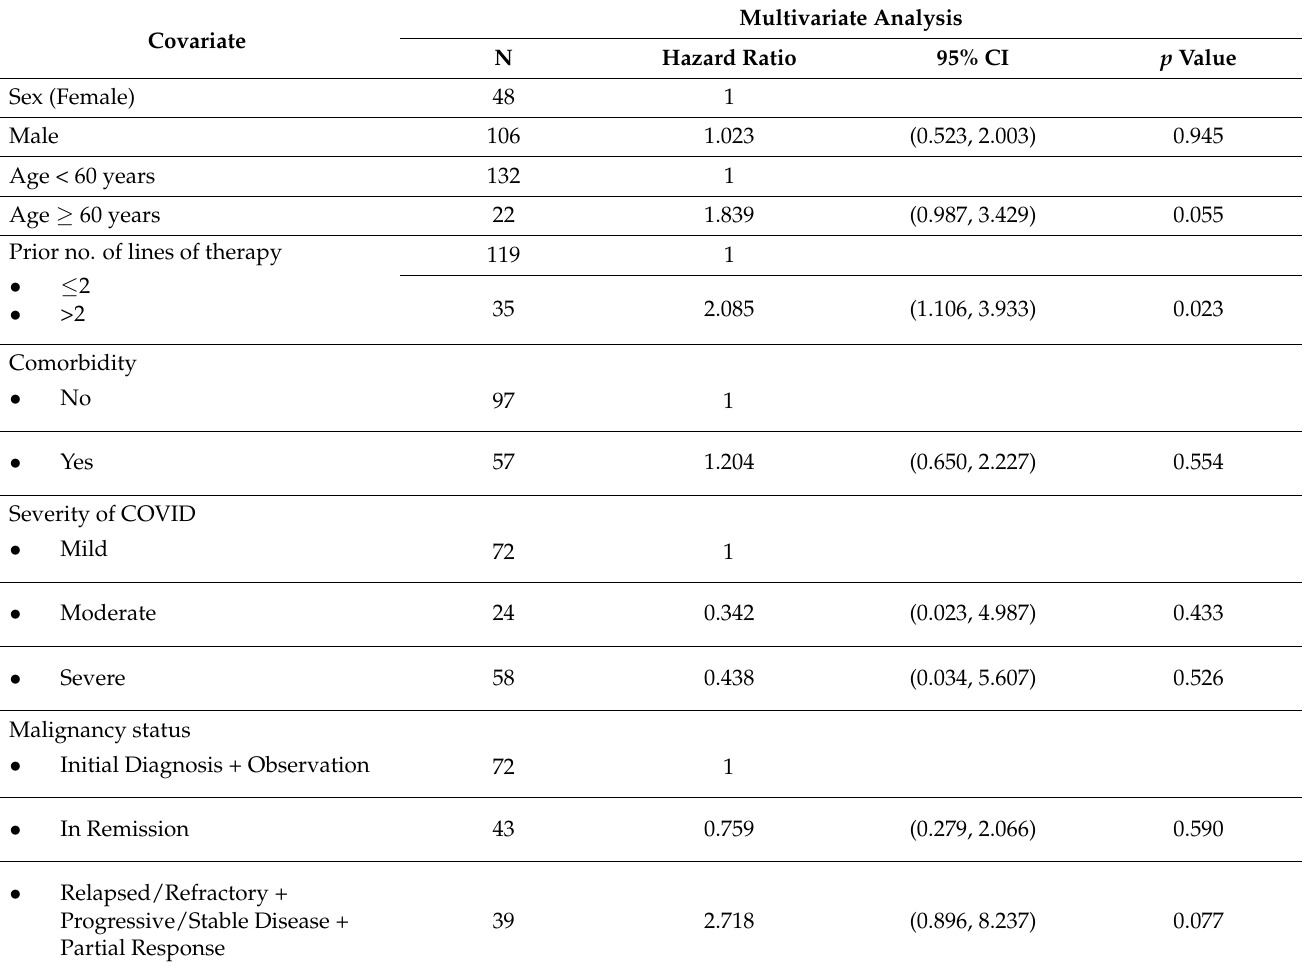
Table 3. Predictors of survival from Multivariate Cox regression